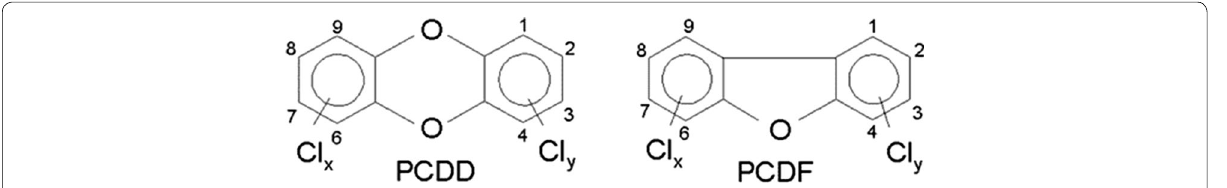
Fig. 1 Structure of PCDD and PCDF (Taken from Frauenhofer